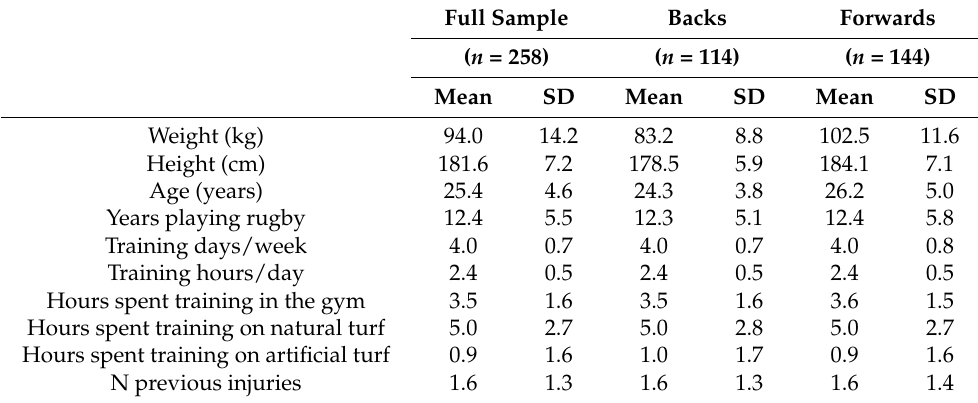
Table 1. Anthropometric data and